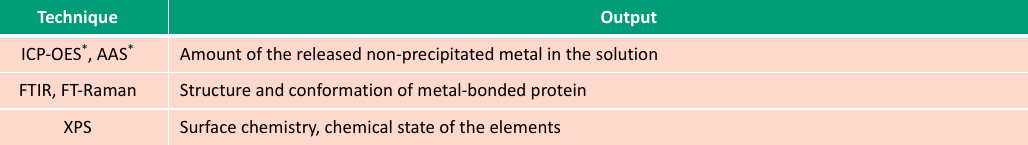
Figure 3. Electrochemical techniques used for investigation of albumin reduction (* in-situ techniques).